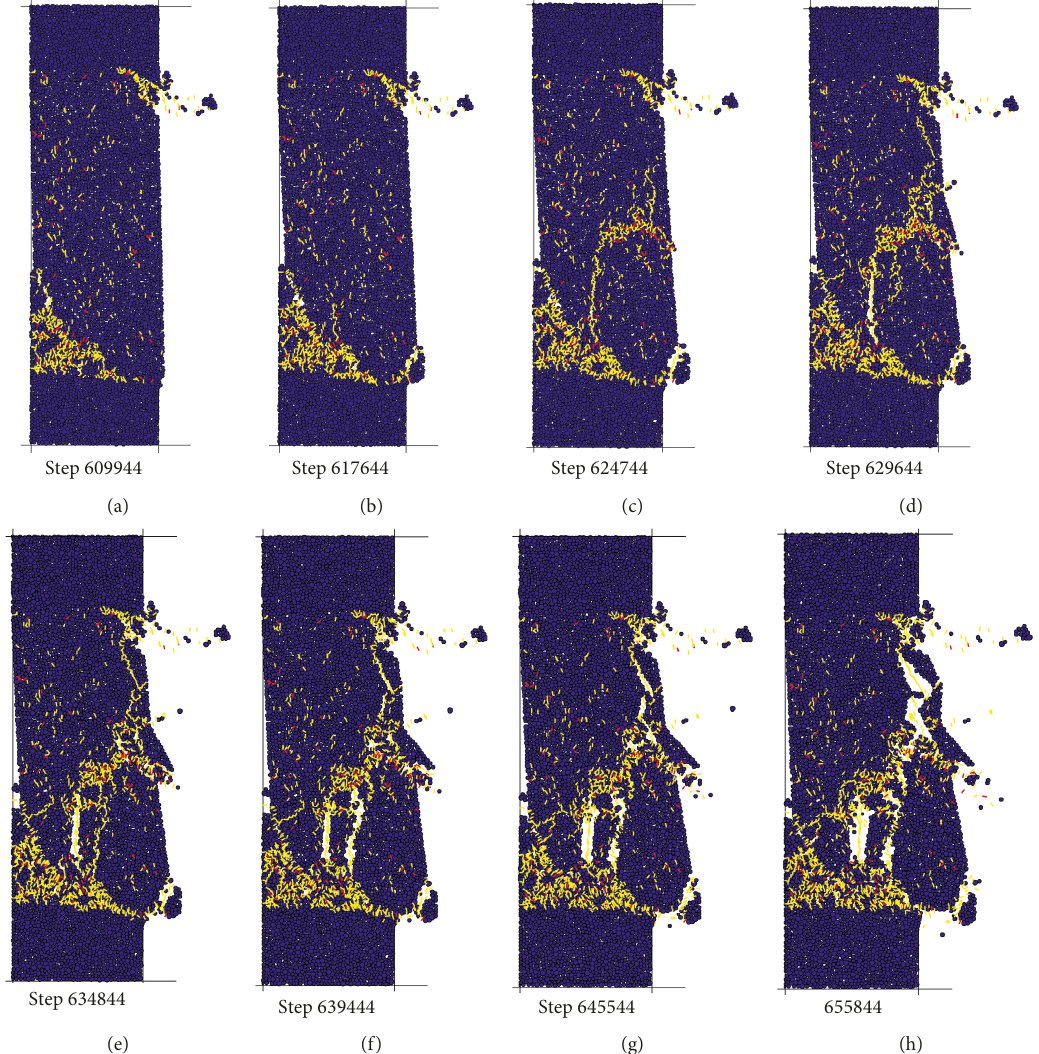
Figure 8: Failure process of # B strain burst test ( R 629644. (e) Step 634844. (f) Step 639444. (g) Step 645544. (h) Step